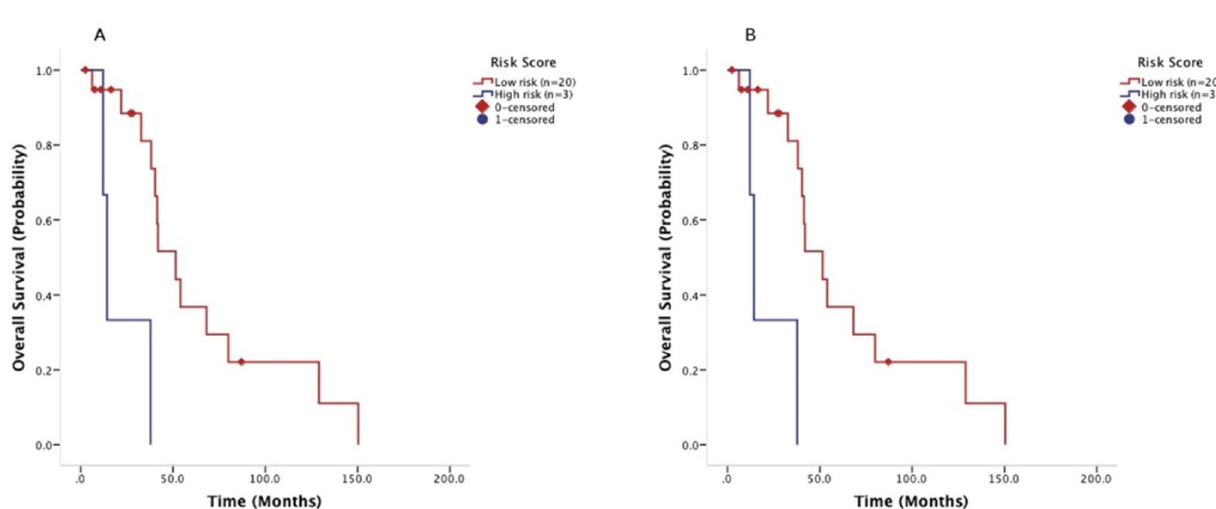
Figure 4. A prognostic model established factors by multivariate analysis of risk factors (age < 45 years old, BMI ≥ 25 kg/m 2 , TP53 mutation, and elevated LDH) for overall survival after initial metastasis diagnosis, was validated in 56 patients with metastatic cancer harboring CCNE1 amplification who received phase I trial therapy ( A ) and in 23 patients who did not receive phase I trial therapy ( B ) Kaplan–Meier curves estimate overall survival after initial phase I trial clinic visit, stratified by risk score (low-risk group with ≤ 1 risk factor and high-risk group with > 1 risk